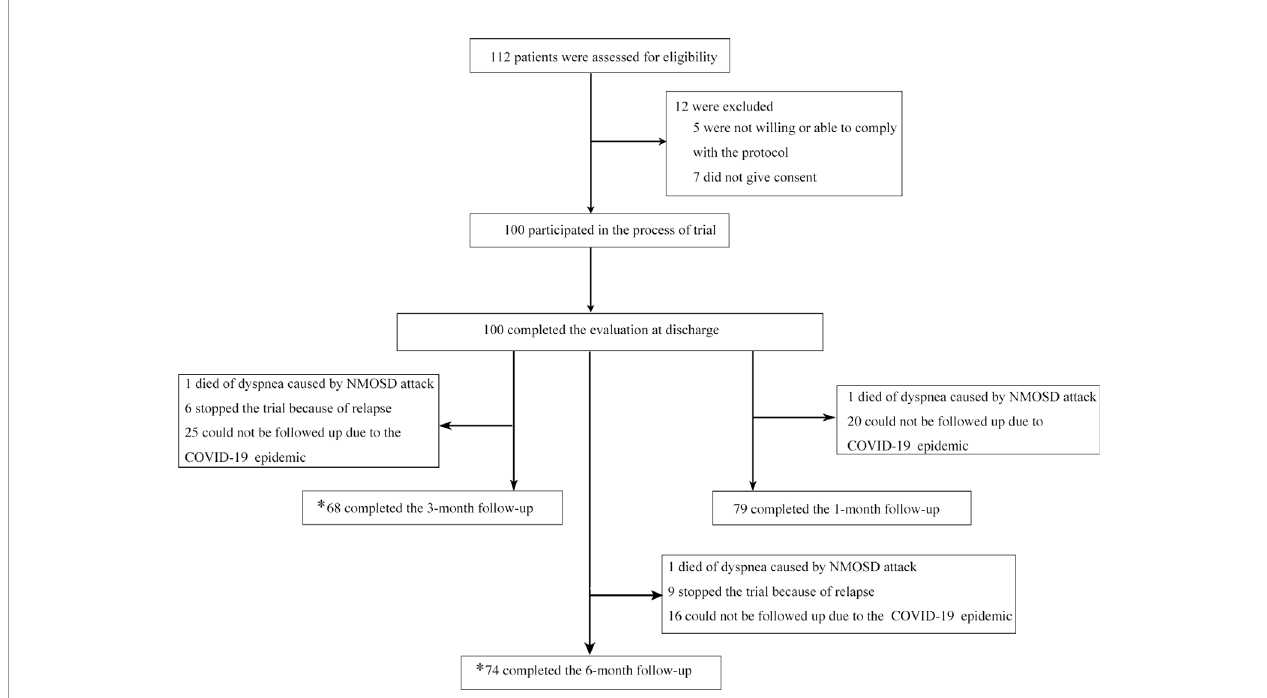
FIGURE 1 | Enrollment and Follow-up. *one follow-up is counted as long as the time-point is correct regardless of whether the previous follow-up was completed or